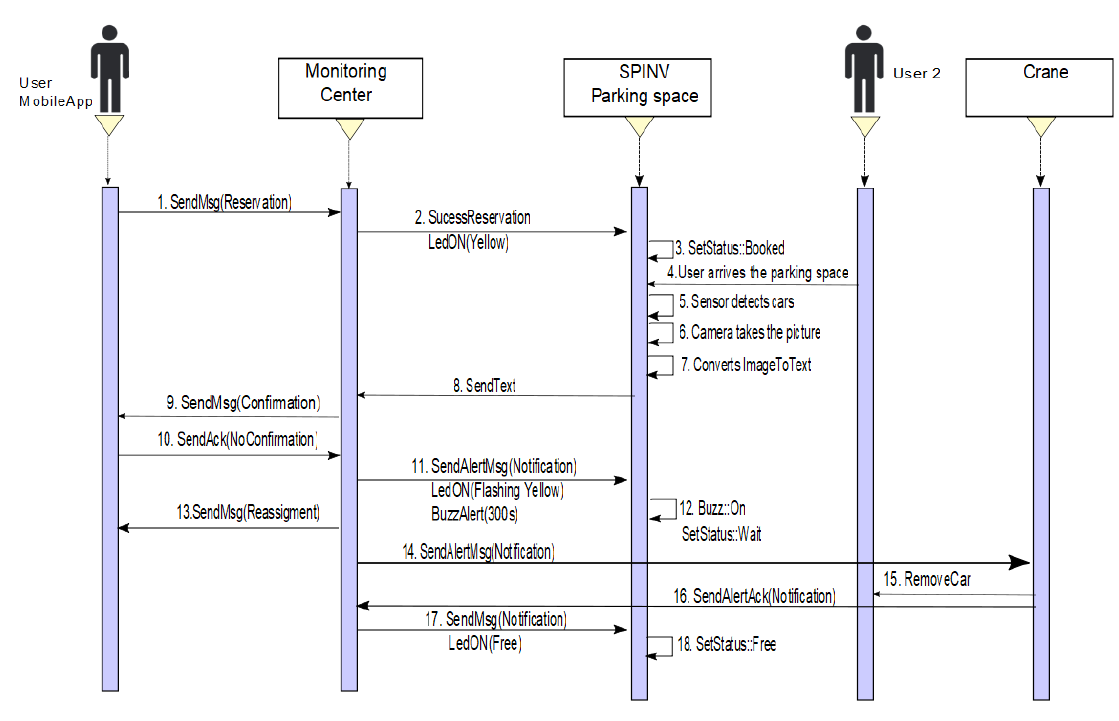
Figure 8. Sequence diagram of Scenario 2b. Reserve/someone else park in the space and the car does not leave the